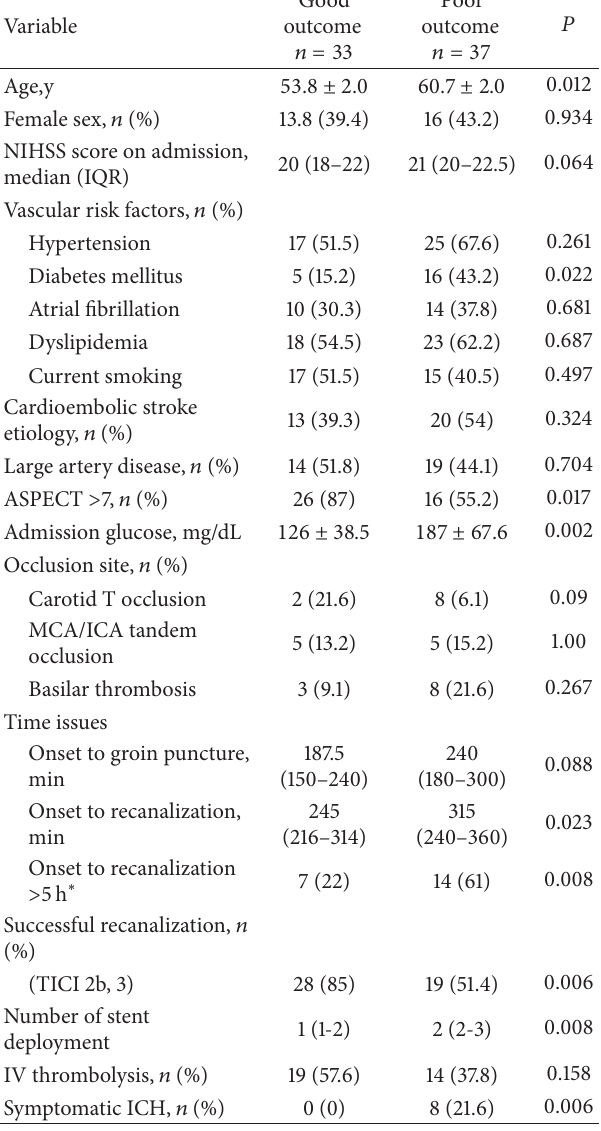
Table 3: Predictors of good clinical